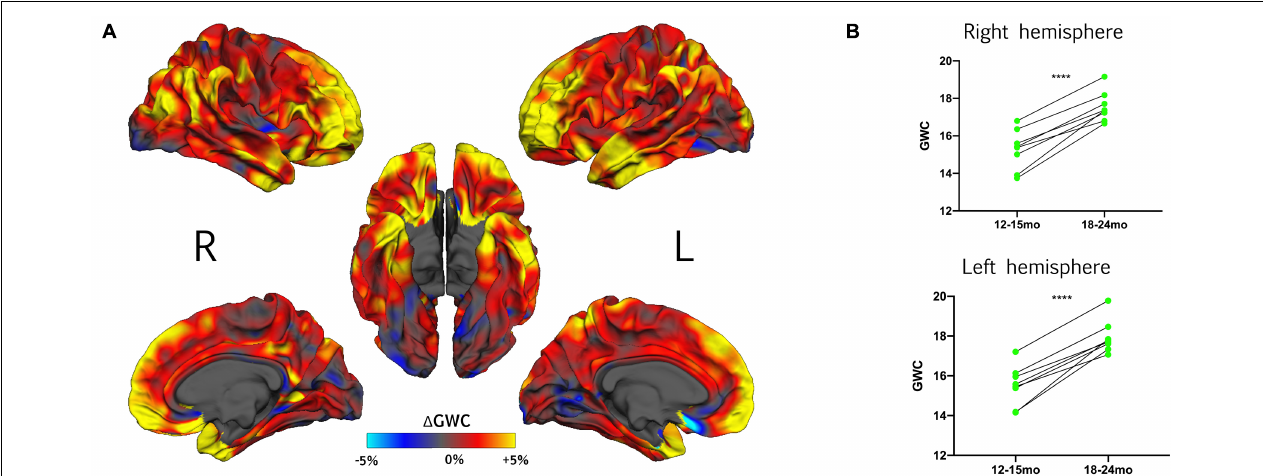
FIGURE 2 | (A) Effect of time on GWC within HR toddlers with typical development outcome at 3 years (HR-TD) represented with vertex-wise (cid:49) GWC values mapped on the common FreeSurfer template. (B) For each hemisphere, individual trajectories of gray-white matter contrast (GWC) from 12–15 to 18–24 months within the HR-TD group. Individual GWC displayed are the average of all vertex-wise values extracted from clusters with a significant effect of time on GWC (one per hemisphere, see Supplementary Figure 2 ). Right hemisphere: 12–15-mo GWC = 15.3% ± 1.1; 18–24 GWC = 17.6% ± 0.8. Left hemisphere: 12–15- months